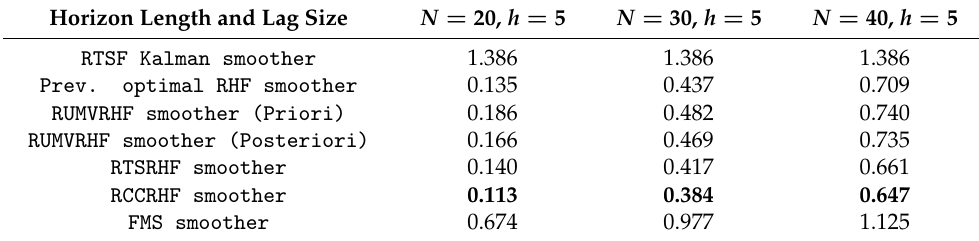
Figure 5. Estimation errors with respect to various horizon lengths ( h = 5). Table 1. RMSE errors for the time interval [ 50 500 ]